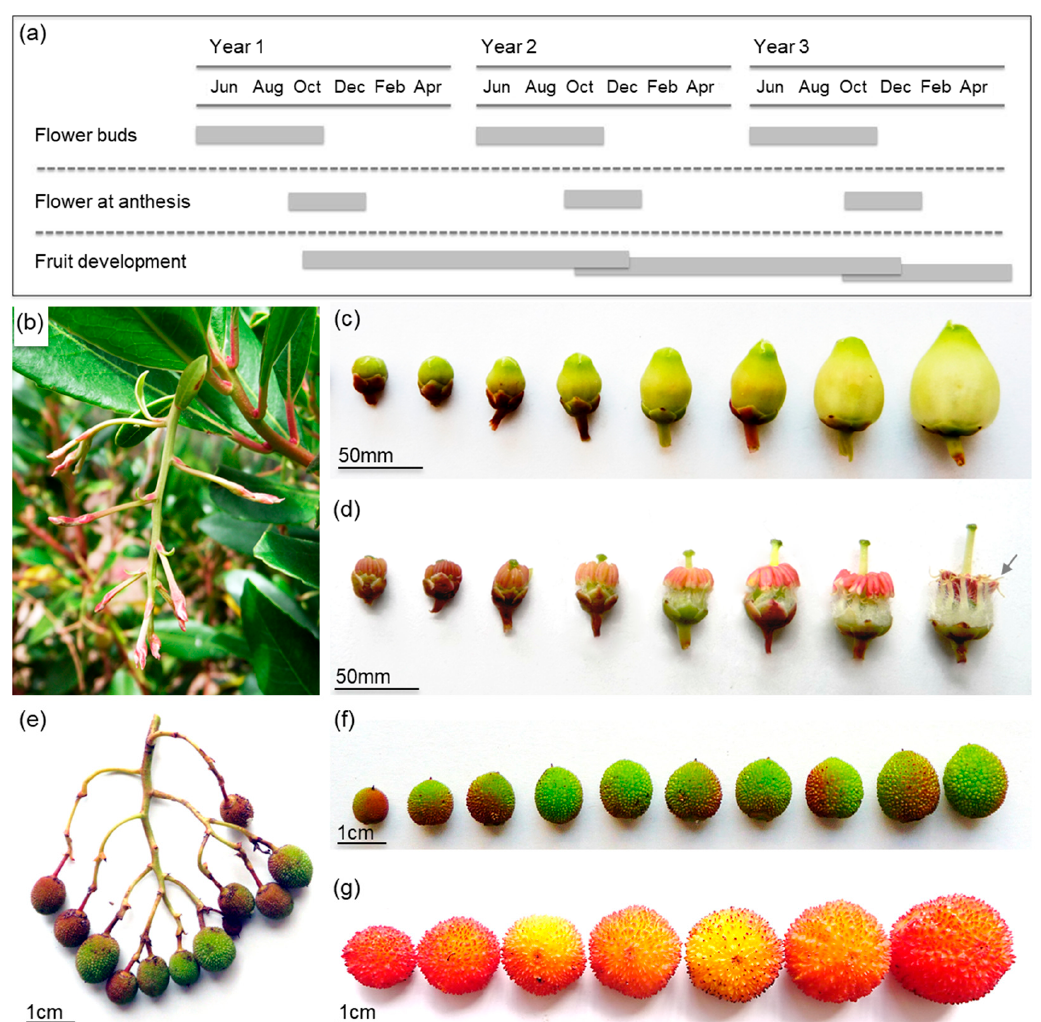
Figure 2. Different aspects of strawberry tree phenology and reproductive anatomy: ( a ) phenological cycle of strawberry tree; ( b ) terminal hanging panicle at an early development stage during June; ( c ) general morphology of the bell-shaped flowers from early stages of development to flower anthesis; ( d ) developmental process of the stamens (arrow indicates anther appendage); ( e ) infructescence at an early development stage; ( f ) fruit developmental stages before ripening; (g)